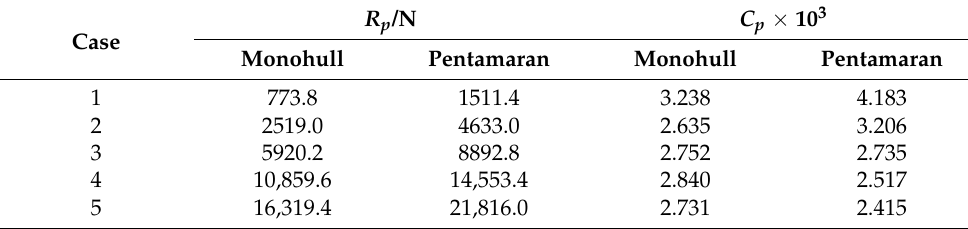
Table 9. Calculation results of pressure resistance.